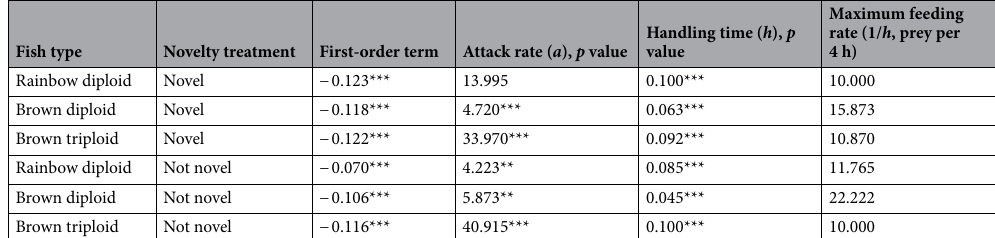
Table 1. First-order terms calculated from logistic regression to denote functional response type across all predator treatments. The significantly negative first-order term values indicate Type II functional responses. Attack rate ( a ), handling time ( h ), maximum feeding rate (1/ h ) parameter estimates were derived using Rogers’ random predator equation (Eq. 1). *** p < 0.001, **p < 0.01. See also Fig. 5.